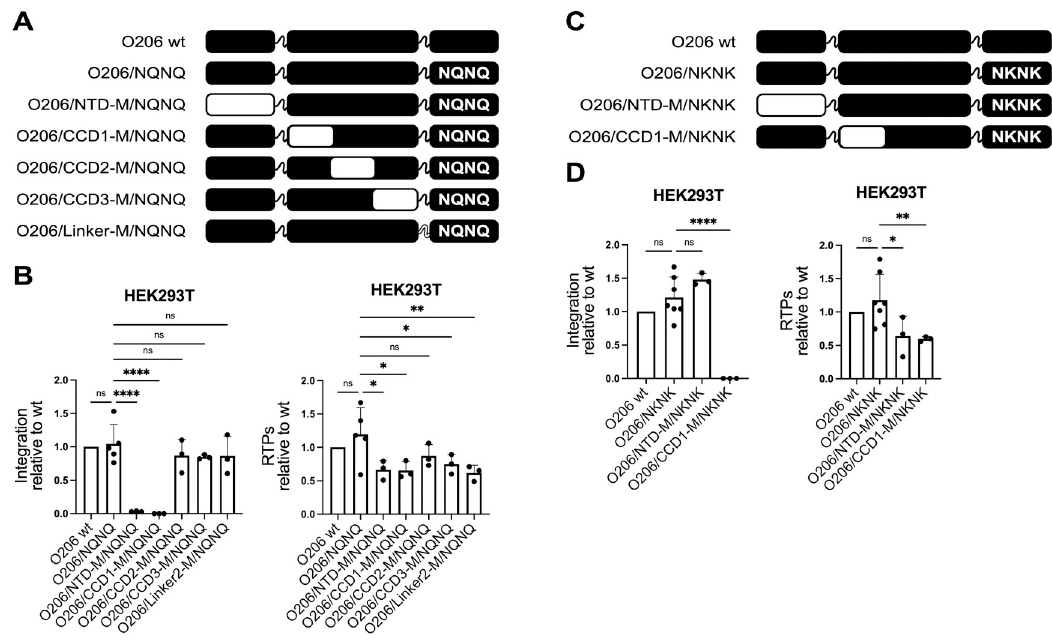
Fig 2. The NTD of isolates O complements the function of the CLA motif of isolate M. ( A ) Schematic representation of the chimeras with the NQNQ sequence in the CLA motif positions and of IN O wt, as reference at the top of the drawing. Color code is black for isolates O and white for isolates M. ( B ) Normalized levels of integration (left graph) and amount of RTPs (right graph), relative to the wt IN, for the chimeras shown in panel A (n = 5 for O206 wt and O206/NQNQ, n = 3 for the remaining samples). ( C ) Schematic representation of the mutants used to discern whether the loss of functionality of the two chimeras shown in panel B is related to the functionality of the CLA motif. ( D ) Normalized levels of integration (left graph) and amount of RTPs (right graph), relative to the wt IN, for the chimeras shown in panel C (n = 7 for O206 wt and O206/NKNK, n = 3 for the remaining samples). Data are shown as the average ± SD. ���� p � 0.0001. �� p � 0.01. � p � 0.05. ns, not significant (one-way ANOVA with Tukey’s multiple comparisons